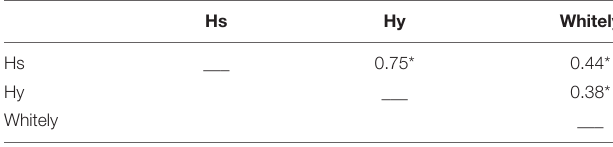
TABLE 1 | Correlations between individual difference measures of health